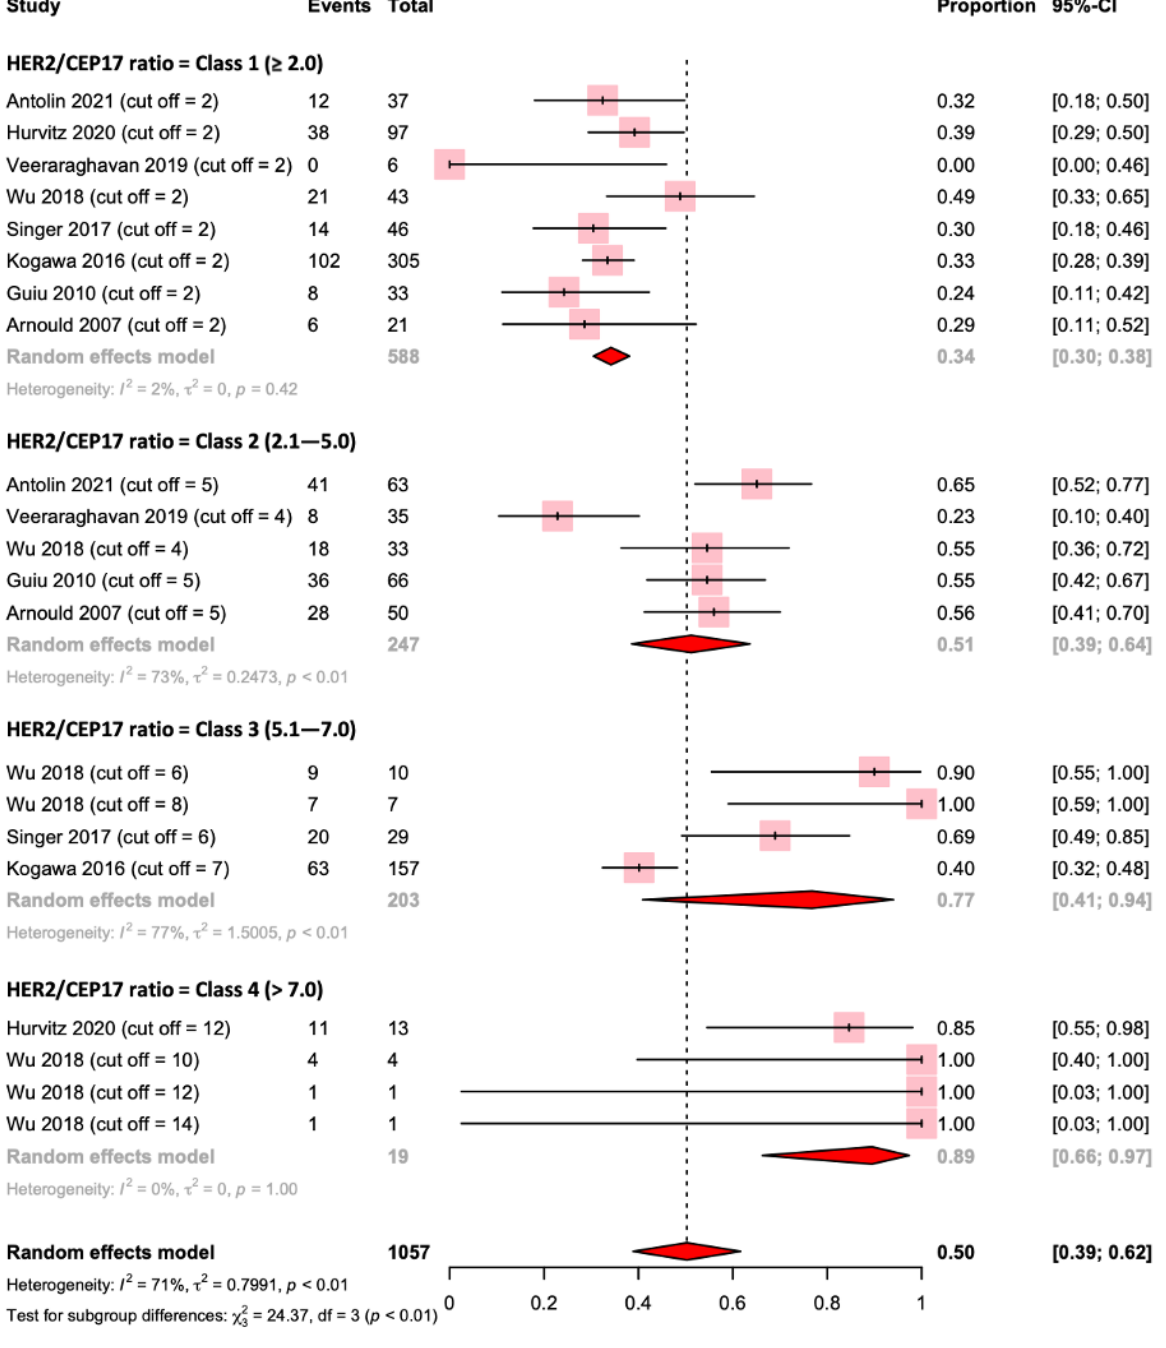
Figure 5. Forest plot for pathological complete response according to the HER2 interval (quartiles) and excluding the study by Greenwell et al. [31,33–40].